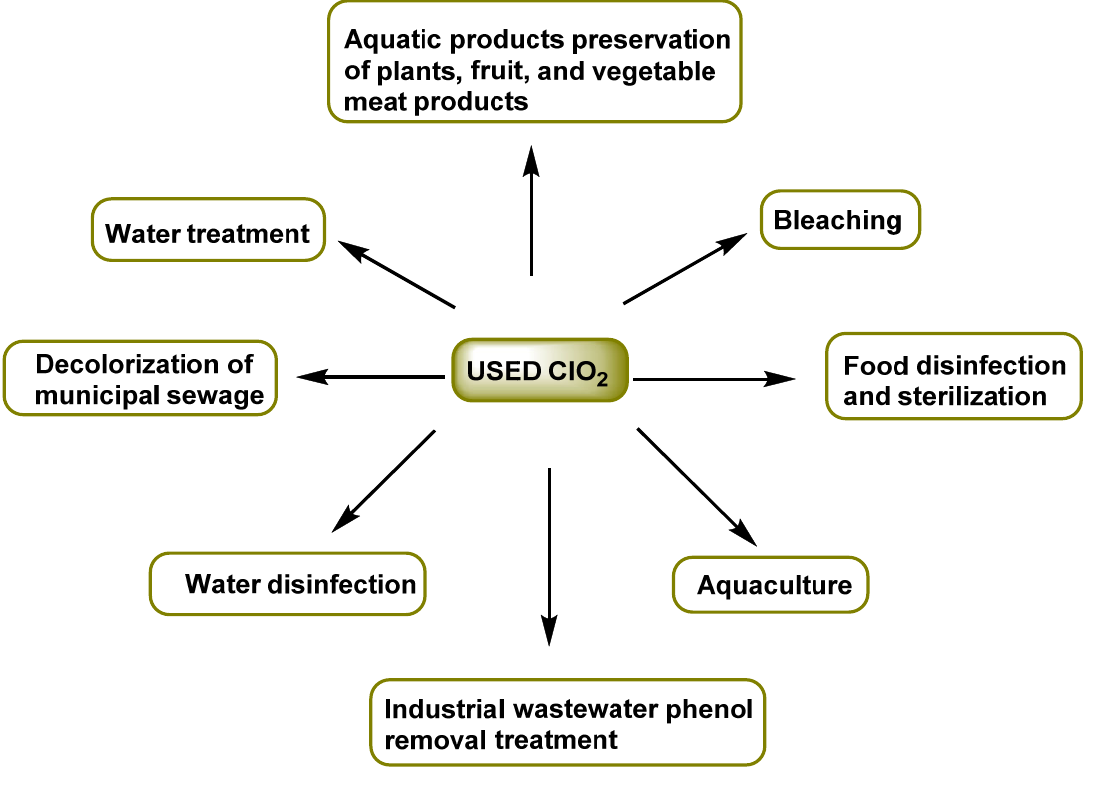
Figure 1. Applications of chlorine dioxide.